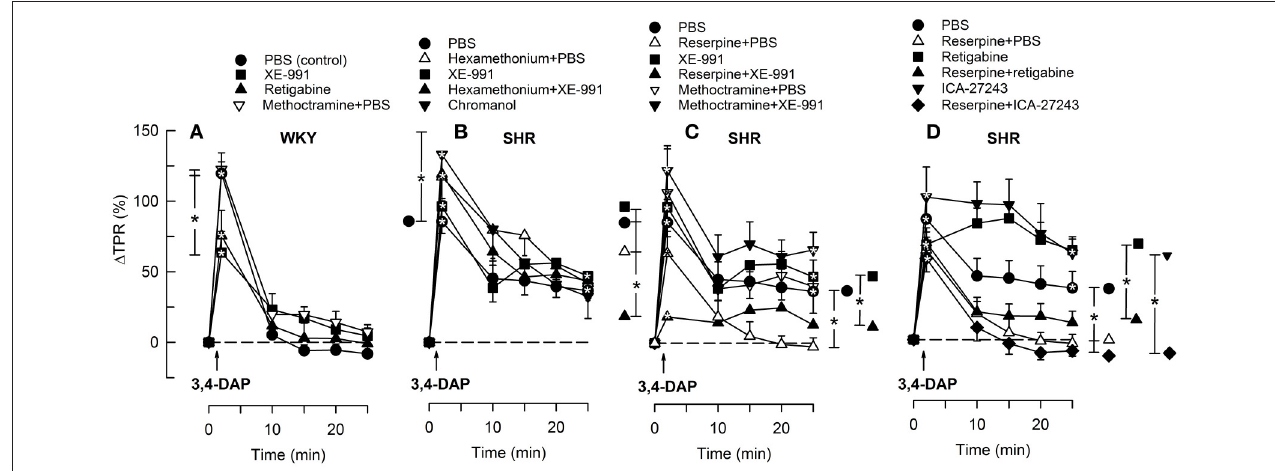
FIGURE 5 | The TPR-response to 3,4-DAP in WKY (A) and SHR (B–D) after pre-treatment with Kv7-opener or -inhibitor, alone or combined with hexamethonium, reserpine or methoctramine, as indicated by symbol legends. Significant responses (* within symbol) and group differences (* in brackets) at about 1 (at the TPR-peak-response) and at 25min were located as indicated. Comparisons were made between corresponding control and experimental groups, and between groups pre-treated with corresponding channel opener/inhibitor alone and hexamethonium/reserpine/methoctramine + channel opener/inhibitor. * P < 0.025 after curve